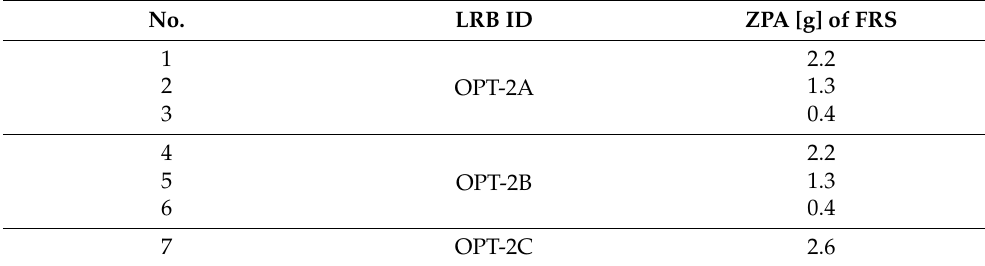
Figure 12. Schematics of the 3D shaking table test. Table 7. Shaking table Test-II procedures and X-dir. seismic inputs [137 ft].